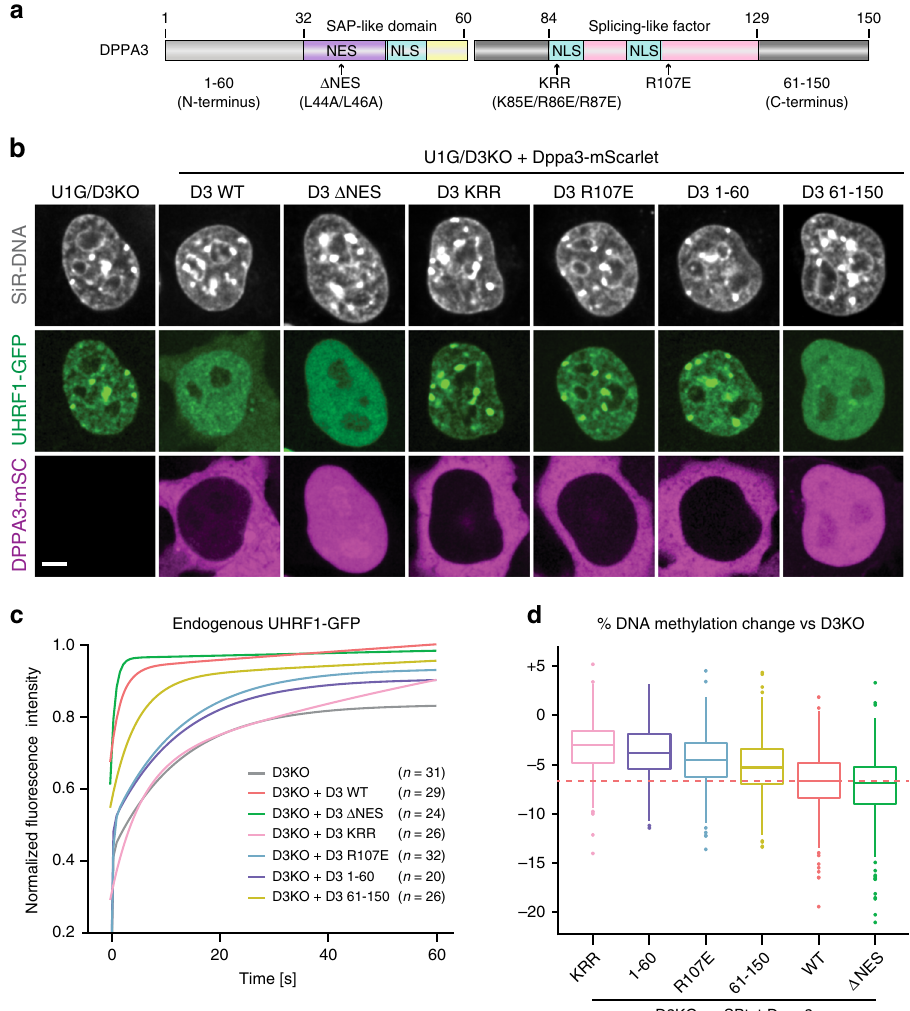
Fig. 5 DPPA3-mediated demethylation is achieved via inhibition of UHRF1 chromatin binding and attenuated by nuclear export. a Schematic illustration of murine DPPA3 with the nuclear localization signals (NLS), nuclear export signal (NES), and predicted domains (SAP-like and splicing factor-like 210 ) annotated. For the DPPA3 mutant forms used in this study, point mutations are indicated with arrows ( Δ NES, KRR, R107E) and the two truncations are denoted by the middle break (1 – 60, left half; 61 – 150, right half). b , c Nuclear export and the N-terminus of DPPA3 are dispensable for disrupting focal UHRF1 patterning and chromatin binding in ESCs. b Representative confocal images illustrating the localization of endogenous UHRF1-GFP and the indicated mDPPA3-mScarlet fusions in live U1G/D3KO + pSB-D3-mSC ESCs after doxycycline induction. DNA counterstain: SiR-Hoechst. Scale bar: 5 μ m. c FRAP analysis of endogenous UHRF1-GFP in U1G/D3KO ESCs expressing the indicated mutant forms of DPPA3. FRAP Curves (solid lines) indicate double-exponential functions fi tted to the FRAP data acquired from n cells (shown in the plots). For single-cell FRAP data and additional quanti fi cation, see Supplementary Fig. 6d – k. d DPPA3-mediated inhibition of UHRF1 chromatin binding is necessary and suf fi cient to promote DNA demethylation. Percentage of DNA methylation change at LINE-1 elements (%) in D3KO ESCs after induction of the indicated mutant forms of Dppa3 as measured by bisul fi te sequencing of n = 4 biological replicates. In the boxplot in ( d ), horizontal lines within boxes represent median values, boxes indicate the upper and lower quartiles, whiskers extend to the most extreme value within 1.5 x the interquartile range from each hinge, and dots indicate outliers. Source data are provided as a Source Data fi